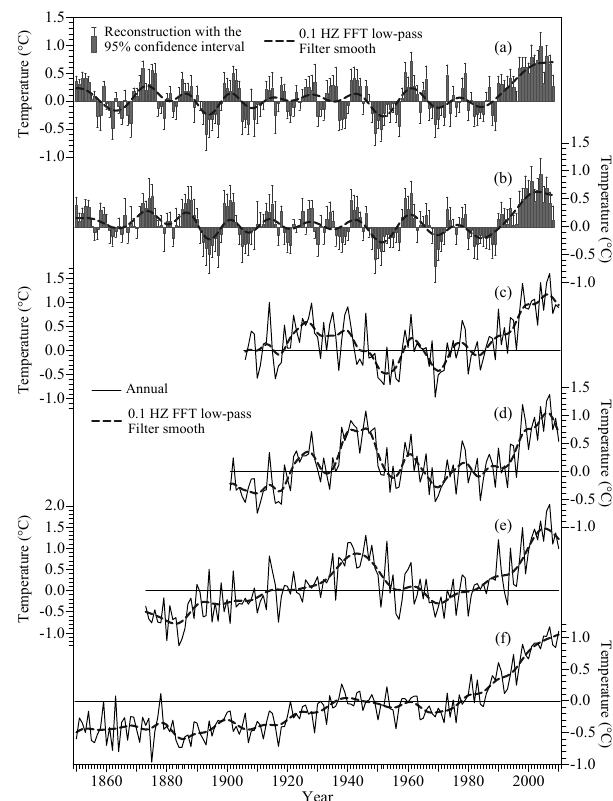
Figure 4. Reconstruction of annual and growing season tempera- ture anomalies (with respect to the mean climatology from 1961 to 1990, as for other series) with a 95% confidence interval in South Central China from 1850 to 2008 and comparison with other ob- servations. (a) Annual temperature reconstruction. (b) Temperature reconstruction for growing season. (c) Observed annual temper- ature anomalies at the Wuhan weather station during 1906–2010 (Cao et al., 2013). (d) Regional mean temperature anomalies from CRU gridded data during 1901–2010. (e) Observed annual temper- ature anomalies at the Shanghai weather station during 1873–2010 (Cao et al., 2013). (f) Northern Hemisphere land air temperature anomalies during 1850–2010 from CRU (http://www.cru.uea.ac.uk/